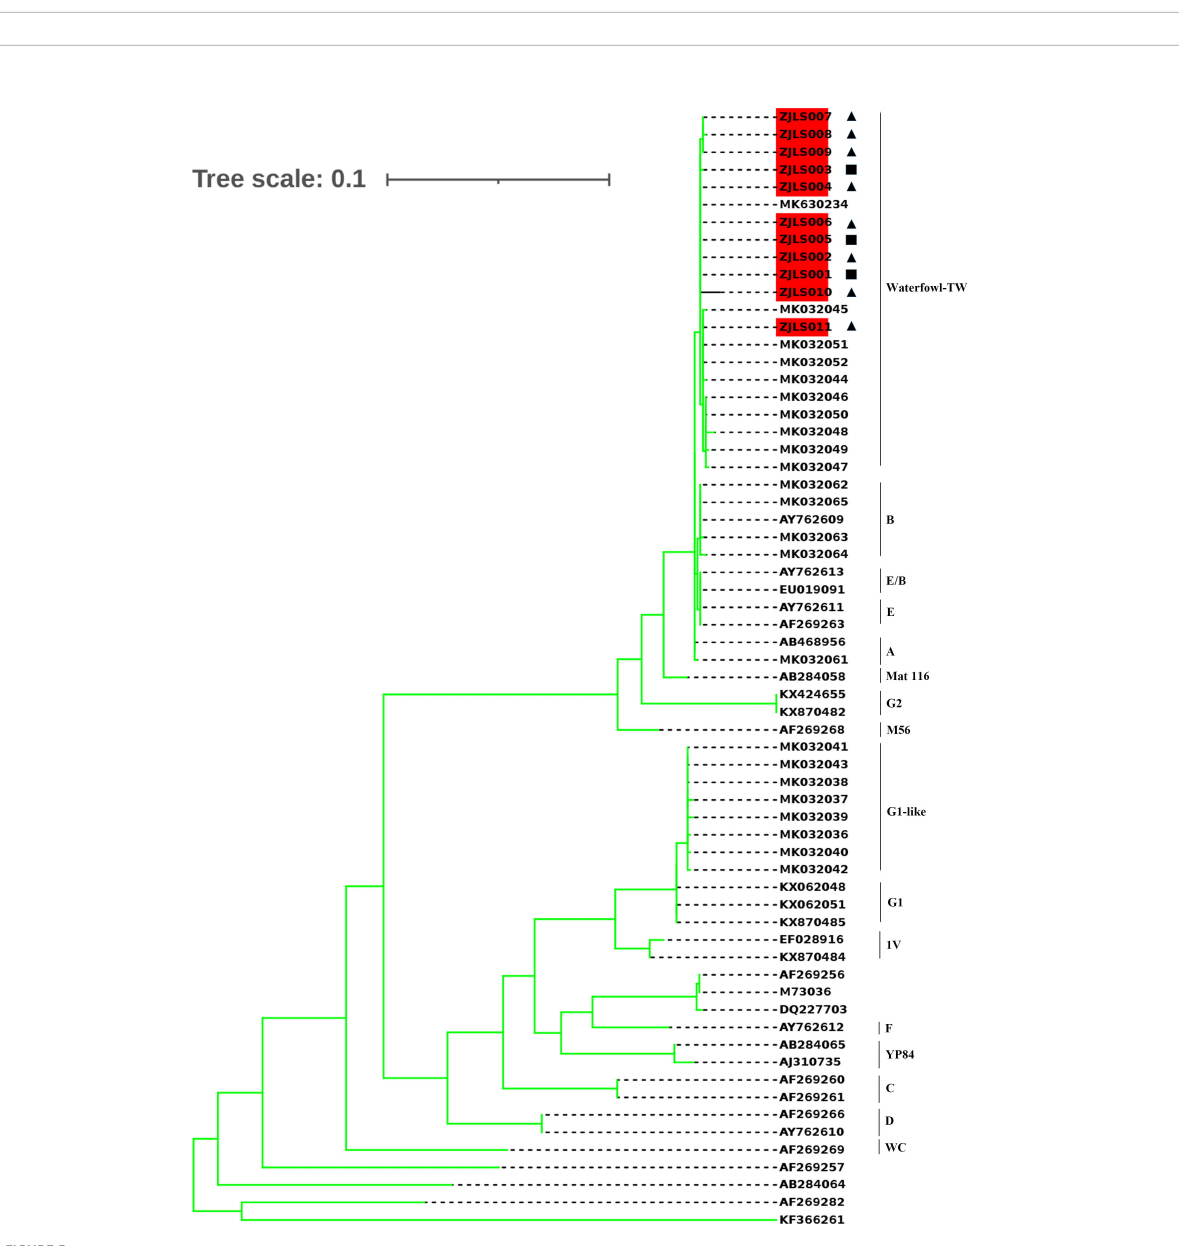
FIGURE 5 Phylogenetic tree of C. psittaci sequences. The 11 sample sequences which are highlighted and 53 reference sequences (the genotype was labled on the right)were compared using Molecular Evolutionary Genetics Analysis (MEGA) software version 7.0 (maximum likelihood phylogeny test) and gamma-distributed rates among sites with 1000 bootstrap replicates. The reference sequences used to construct distinct phylogenetic branches were obtained from GenBank sequence database. ◼ Samples collected from Patient 1. ▲ Samples collected from Patient 2, 3 and